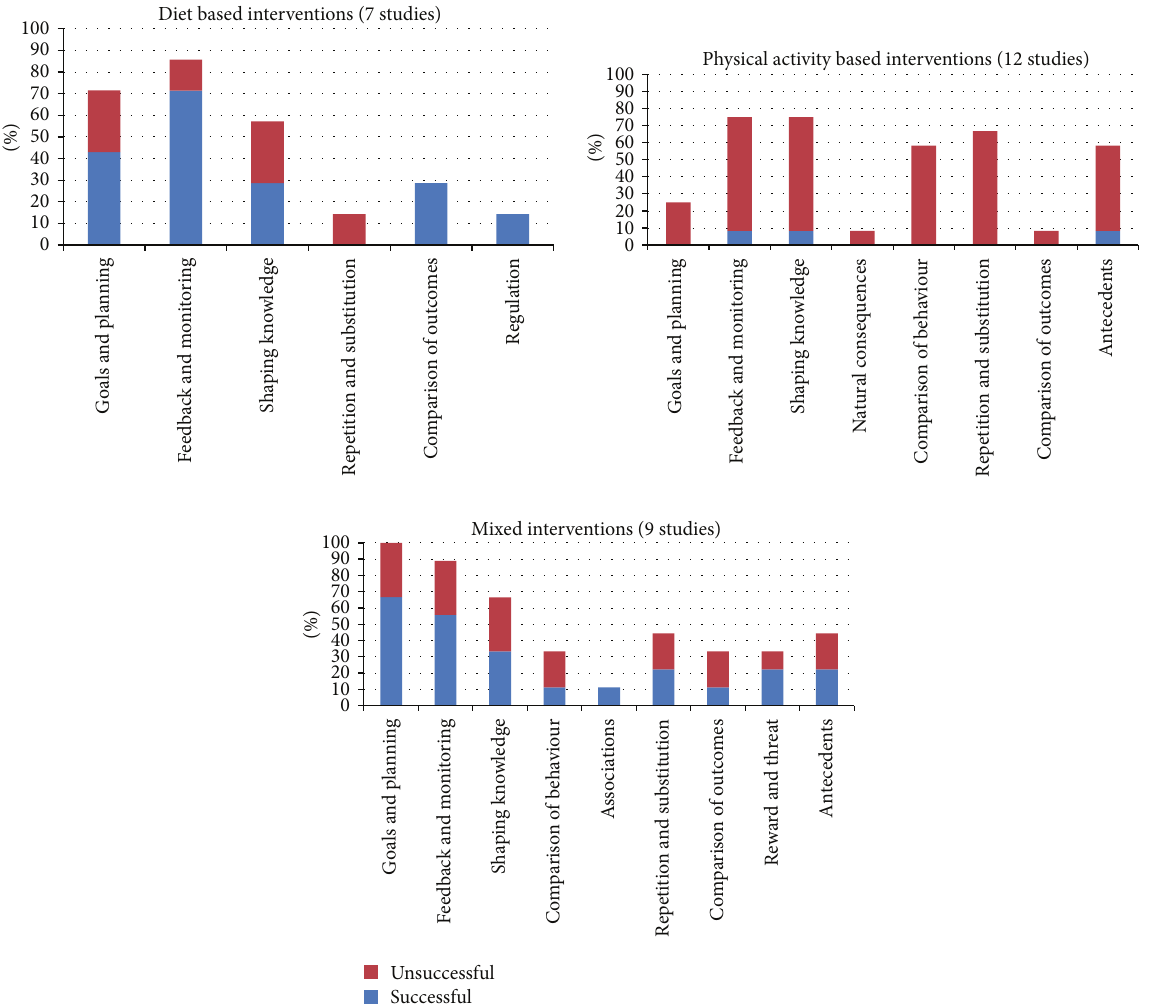
Figure 3: Success of intervention on gestational weight gain across intervention